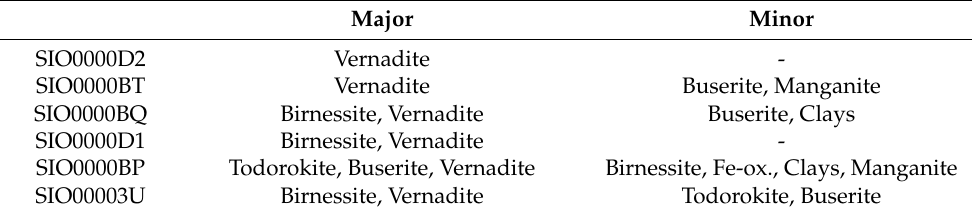
Table 2. Simplified bulk XRD composition of analyzed ferromanganese crust samples from